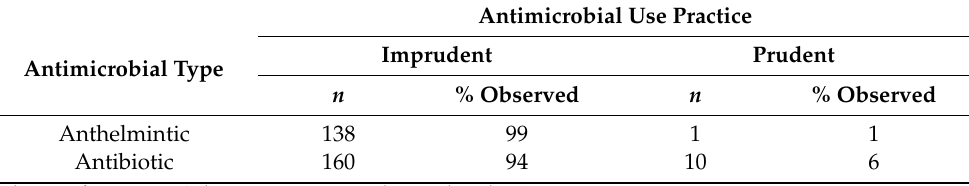
Table 2. The antimicrobial use practice of 309 occasions when antimicrobials were used on 276 enter- prises located in Central and Western divisions of Viti Levu, Fiji. Antimicrobial Use Practice Antimicrobial